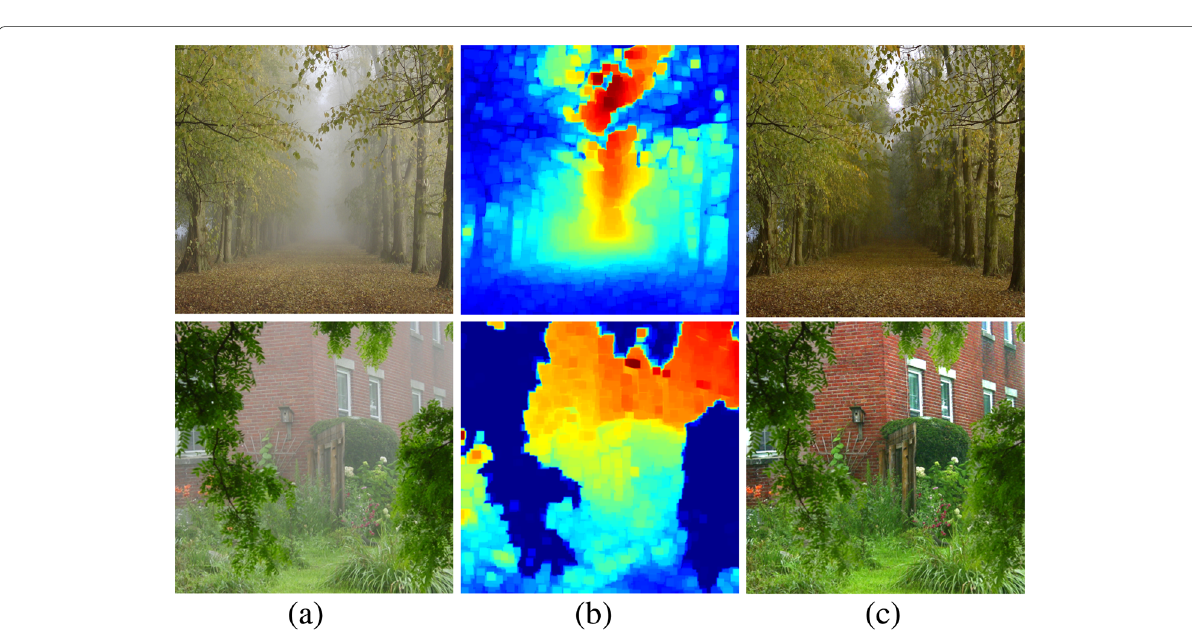
Fig. 5 Result of recovery an image using the modified dark channel prior. a Hazy input. b Dark channel map. c